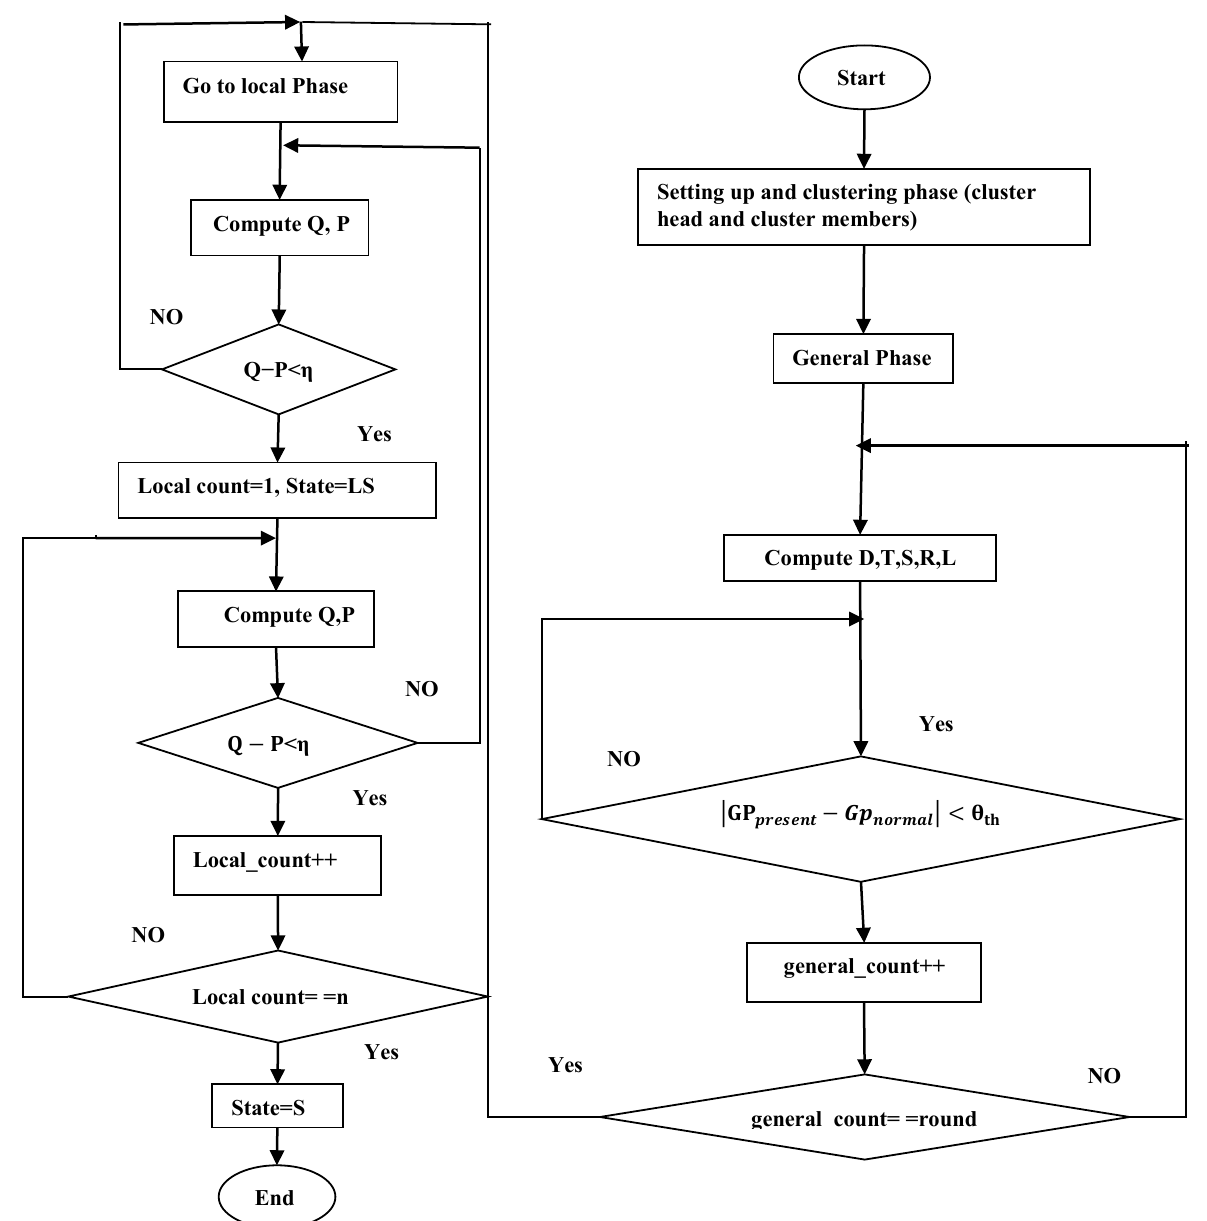
Fig. 4. Flowchart of the proposed method with